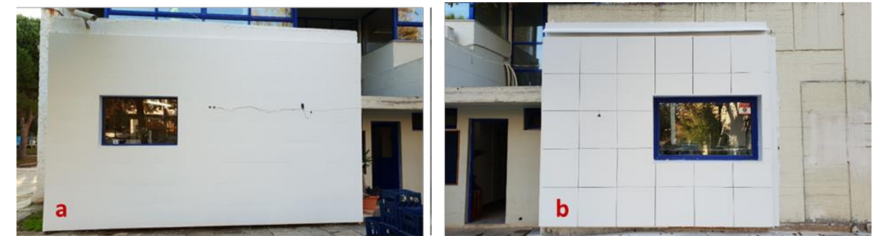
Figure 3. InnoWEE retrofitting: ( a ) ETICS-like panels in Office 1, ( b ) ventilated façade in Office 2 [source: InnoWEE project].